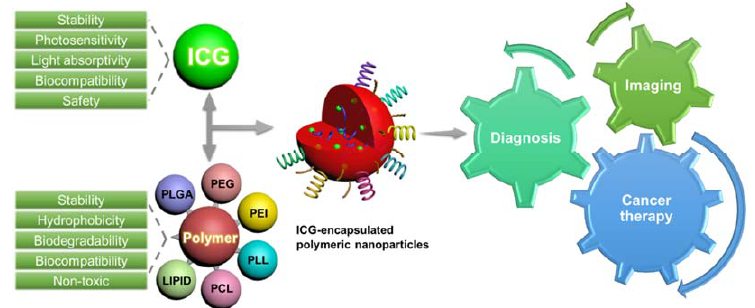
Figure 1. Schematic illustration highlighting the importance of various indocyanine green (ICG)-encapsulated polymeric nanoconstructs that have been utilized for various potential applications such as drug delivery, imaging, and diagnosis.